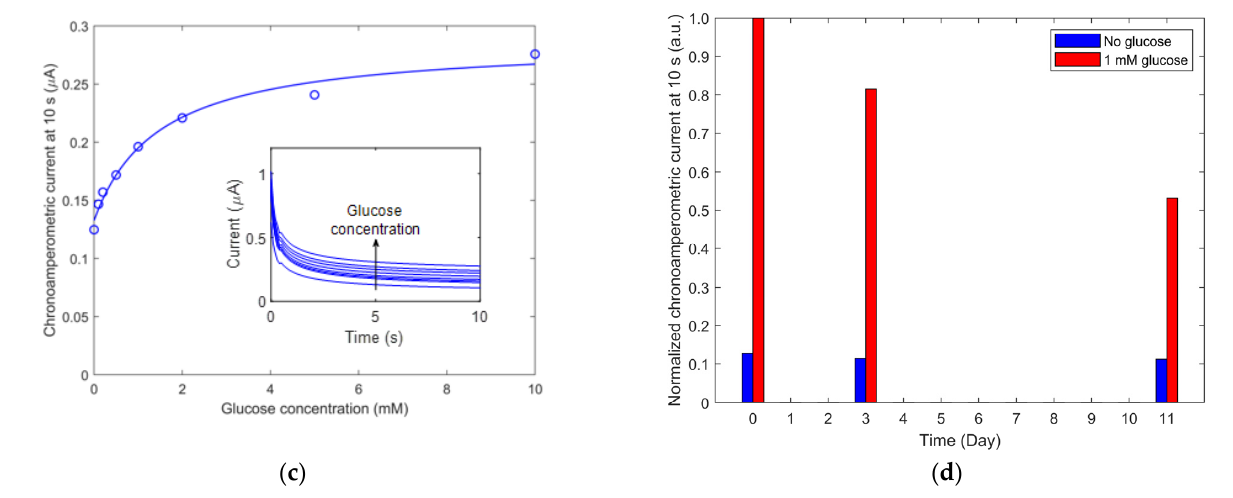
Figure 5. Immersion mode PQQ-GdhB biosensor electrochemical characterization: ( a ) Cyclic voltammogram for different glucose concentrations, measured with large electrodes; ( b , c ) chronoamperometric current dependency on glucose concentration, measured with large and small electrodes. Circles depict measured results and lines depict fitted results; ( d ) normalized chronoamperometric current dependence on storage time for 0 and 1 mM glucose.